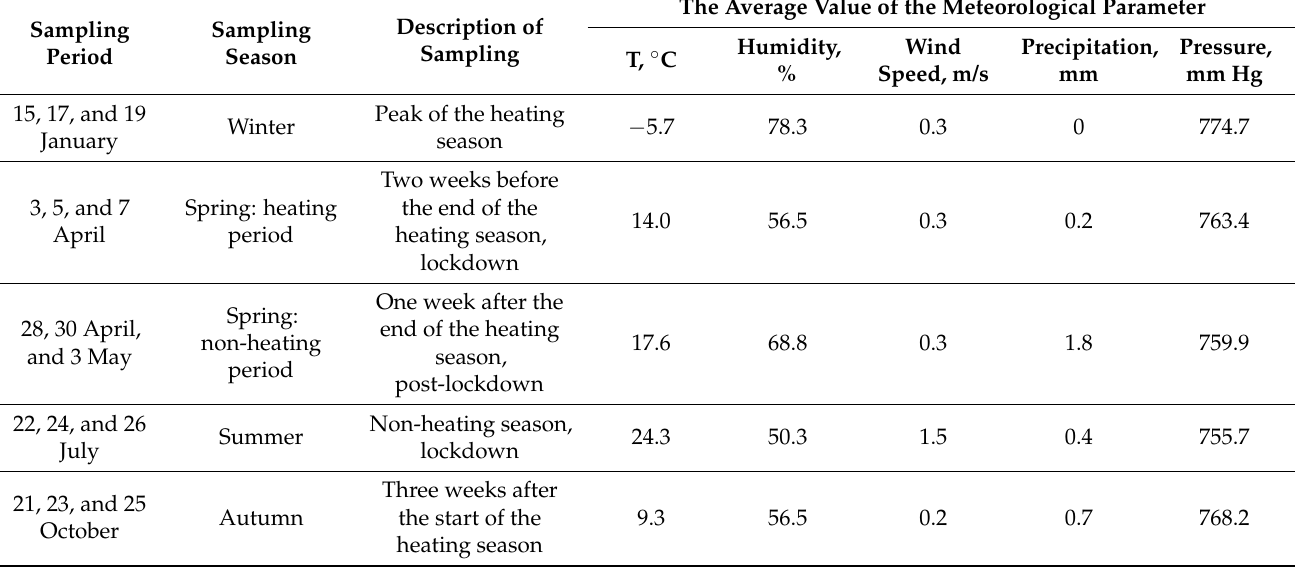
Table 2. Description of VOCs sampling